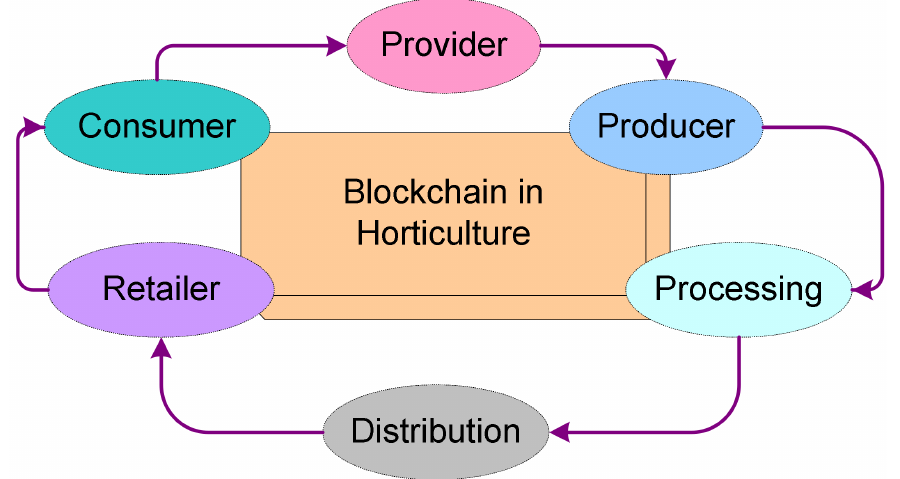
Figure 4. Blockchain technology in